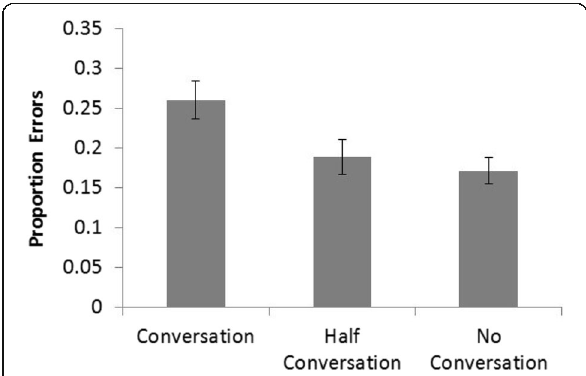
Fig. 9 The proportion of errors for each condition in experiment 3. Error bars represent the standard